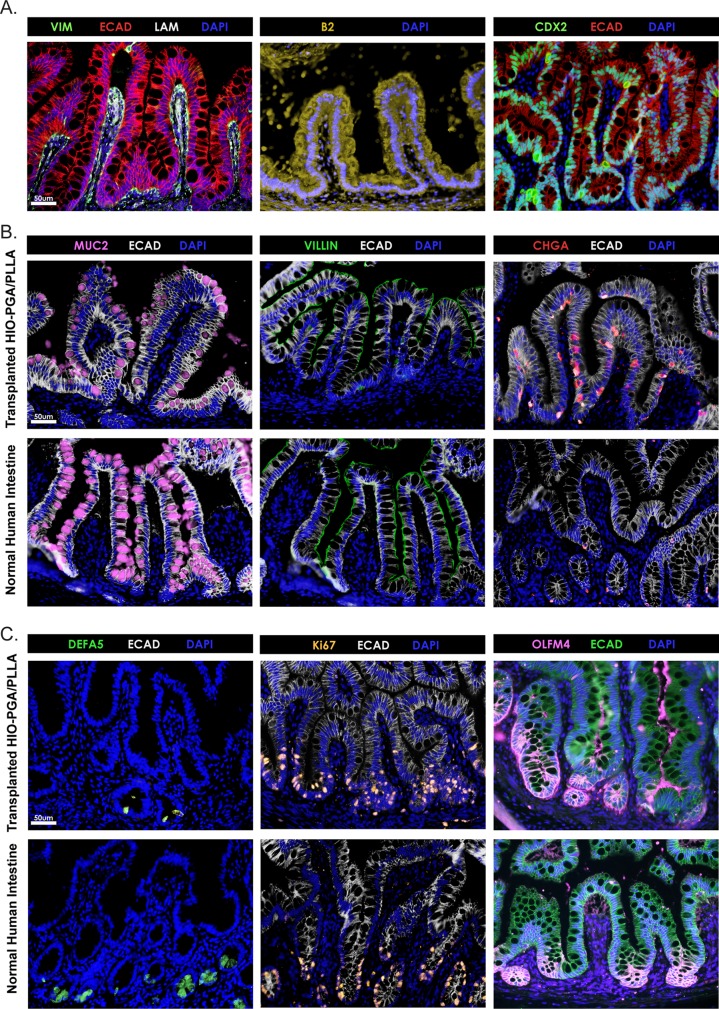
PGA/PLLA scaffolds seeded with HIOs. (A) PGA/PLLA scaffolds were seeded with HIOs, implanted into immunocompromised mice, and analyzed 13 weeks later. HIOs successfully reseeded PGA/PLLA scaffolds and developed villus structures (top left). β2 microglobulin (top middle) and CDX2 (top right) staining confirmed the human and intestinal identities of the cells, respectively. (B) Staining confirms that cells found on the HIO-seeded PGA/PLLA scaffolds include goblet cells (MUC2; top left), enterocytes (VILLIN; top middle), and enteroendocrine cells (chromogranin A, ChgA; top right) which are all cells types that normally reside on the villi. Normal human small intestine is shown for comparison (bottom row). (C) HIO-seeded scaffolds develop crypts where Paneth cells (DEFA5; top left) and proliferating cells (Ki67; top middle) including intestinal stem cells (OLFM4; top right) are concentrated. Normal human small intestine is shown for comparison (bottom row). Scale bars: 50 μm.